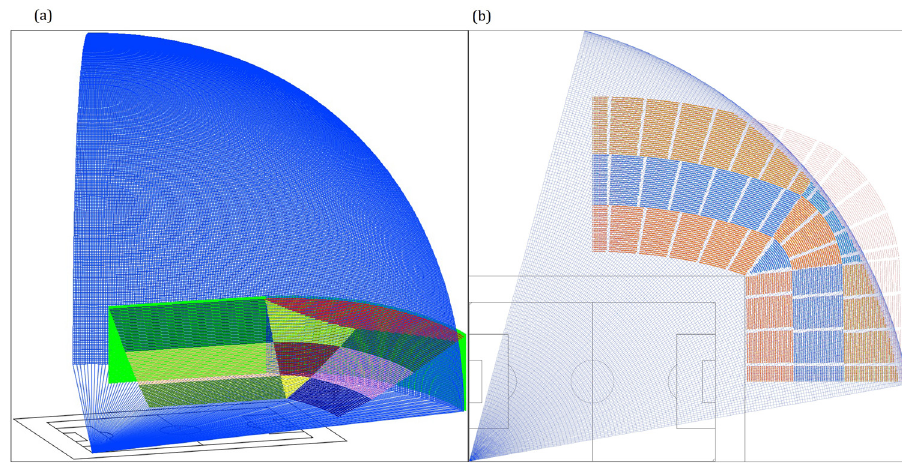
Figure 13: ( a ) Borderline positions of the eye lines ( for RS 175 m = ) and ( b ) stadium stands with 81,928 seats.